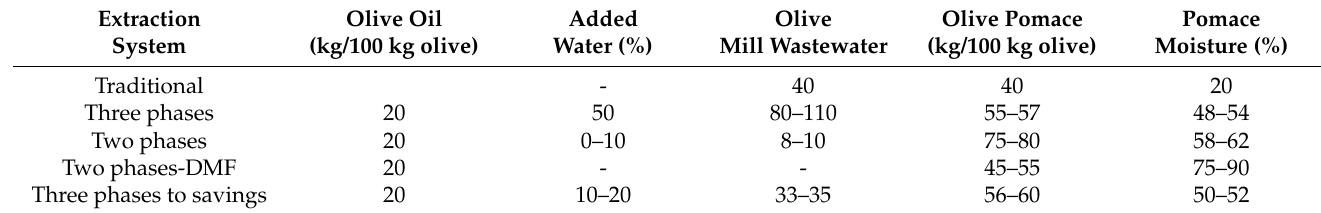
Table 1. Olive oil and by-products from different extraction systems